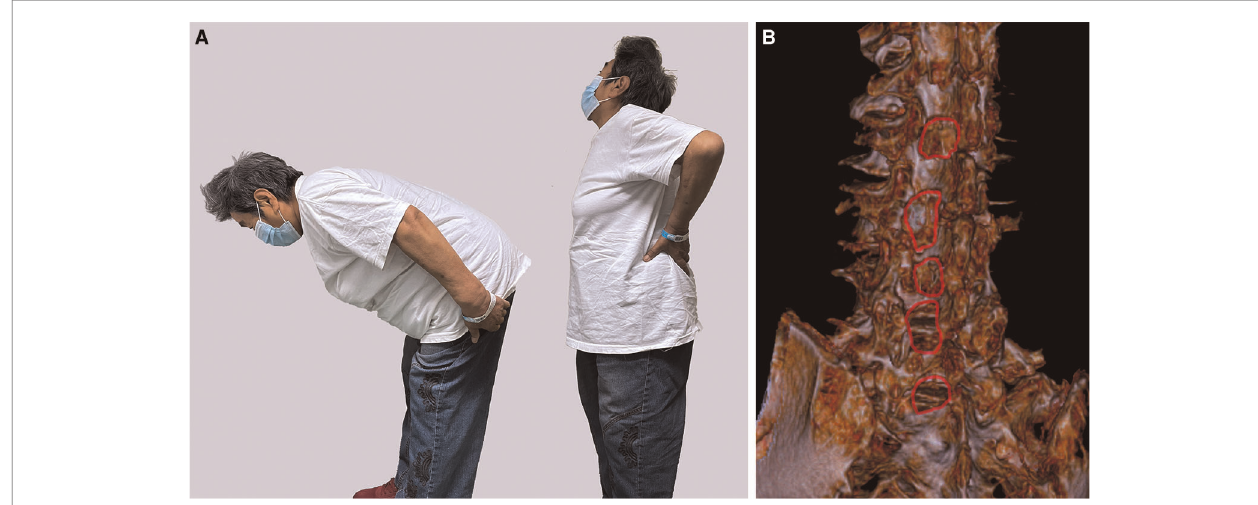
FIGURE 4 | Thepatient achieved favorable fl exion and extension of the back with littlepain ( A ). Regions of bone resection after the two-stage procedure (red circles) ( B ).